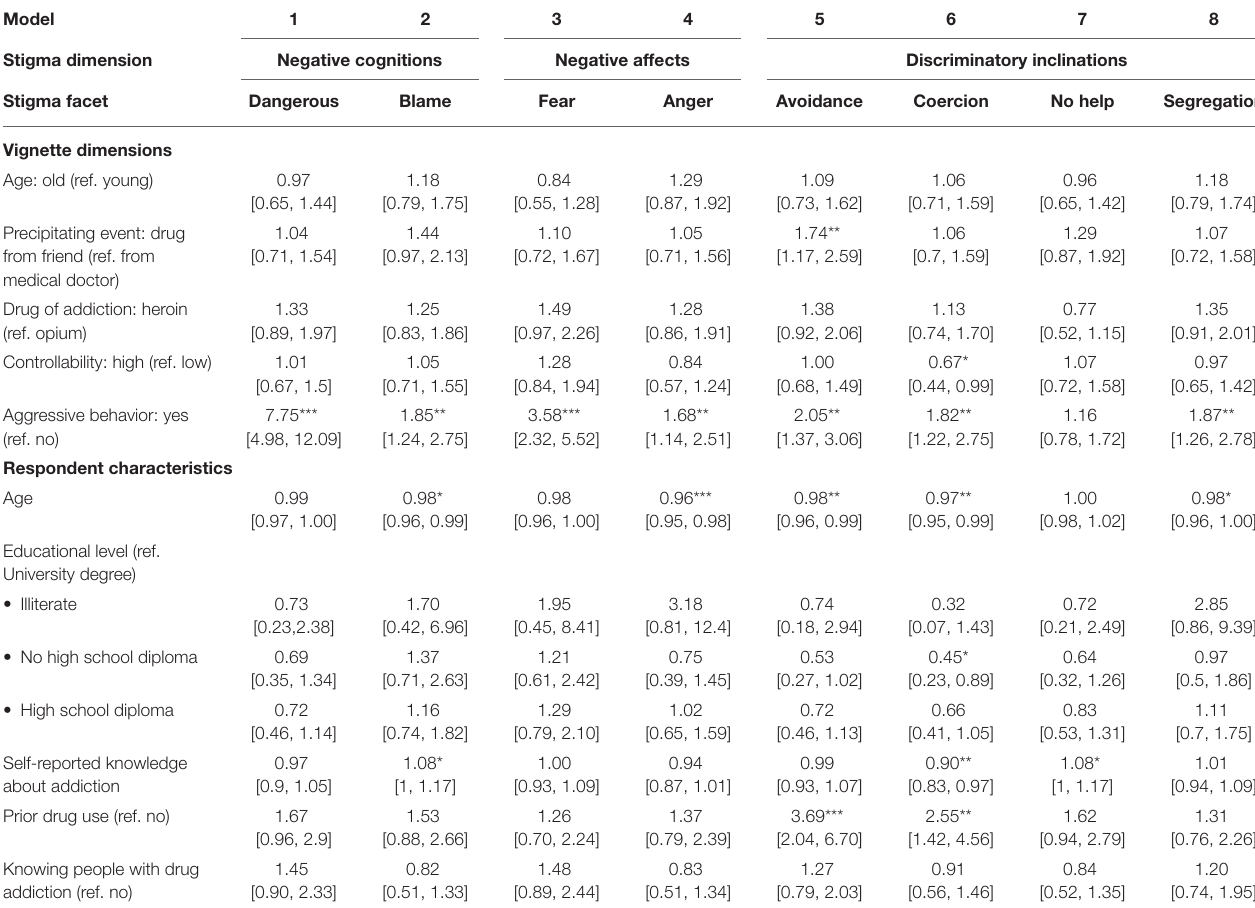
TABLE 4 | Multivariate ordered logit regression models † on the Attribution Questionnaire (AQ) for men ( N = 320), with EM-imputation. Model Stigma dimension Negative cognitions Negative affects Discriminatory inclinations Stigma facet Dangerous Blame Fear Anger Avoidance Coercion No help Segregation Vignette